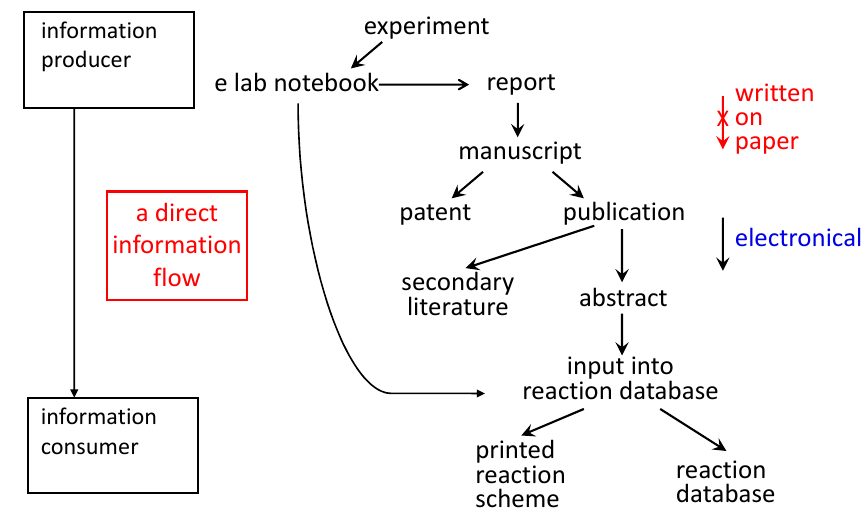
Figure 3. When the experimental observations are written into an electronic laboratory notebook, the information can flow into a variety of different information products without it being